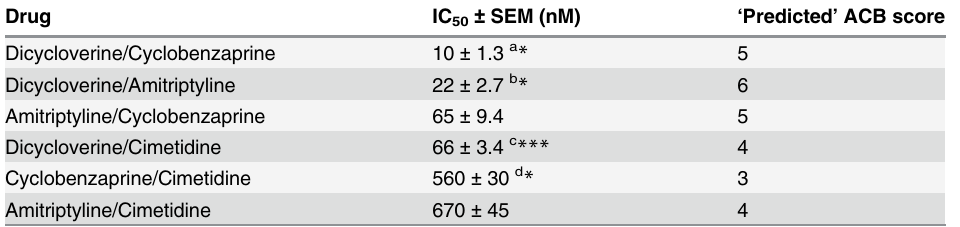
Cyclobenzaprine/Cimetidine 560 ± 30 d * Amitriptyline/Cimetidine 670 ± 45 4 Values represent the mean IC 50 values (n = 3), ± SEM (nM) for each combination of two drugs. Compared IC 50